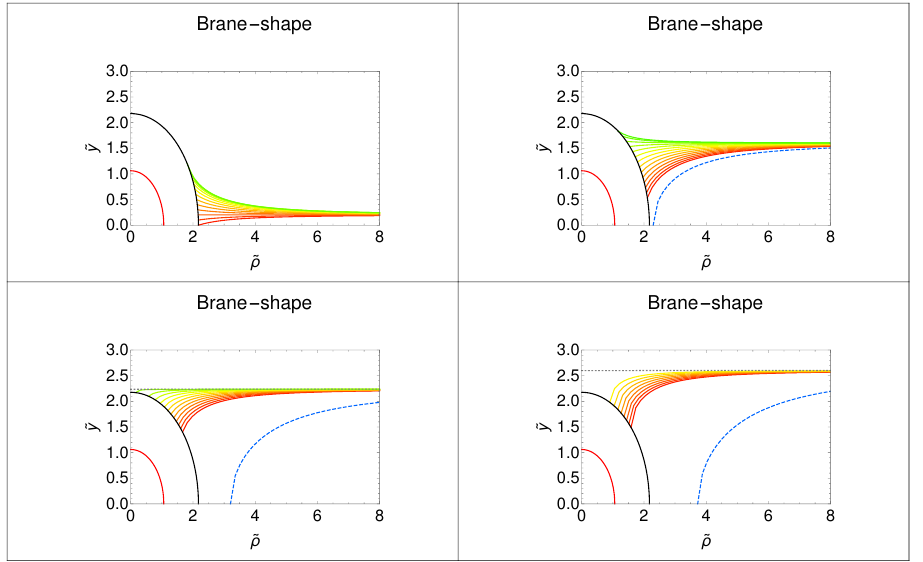
Figure 3 . D-branes in BH geometry for r 0 < r m